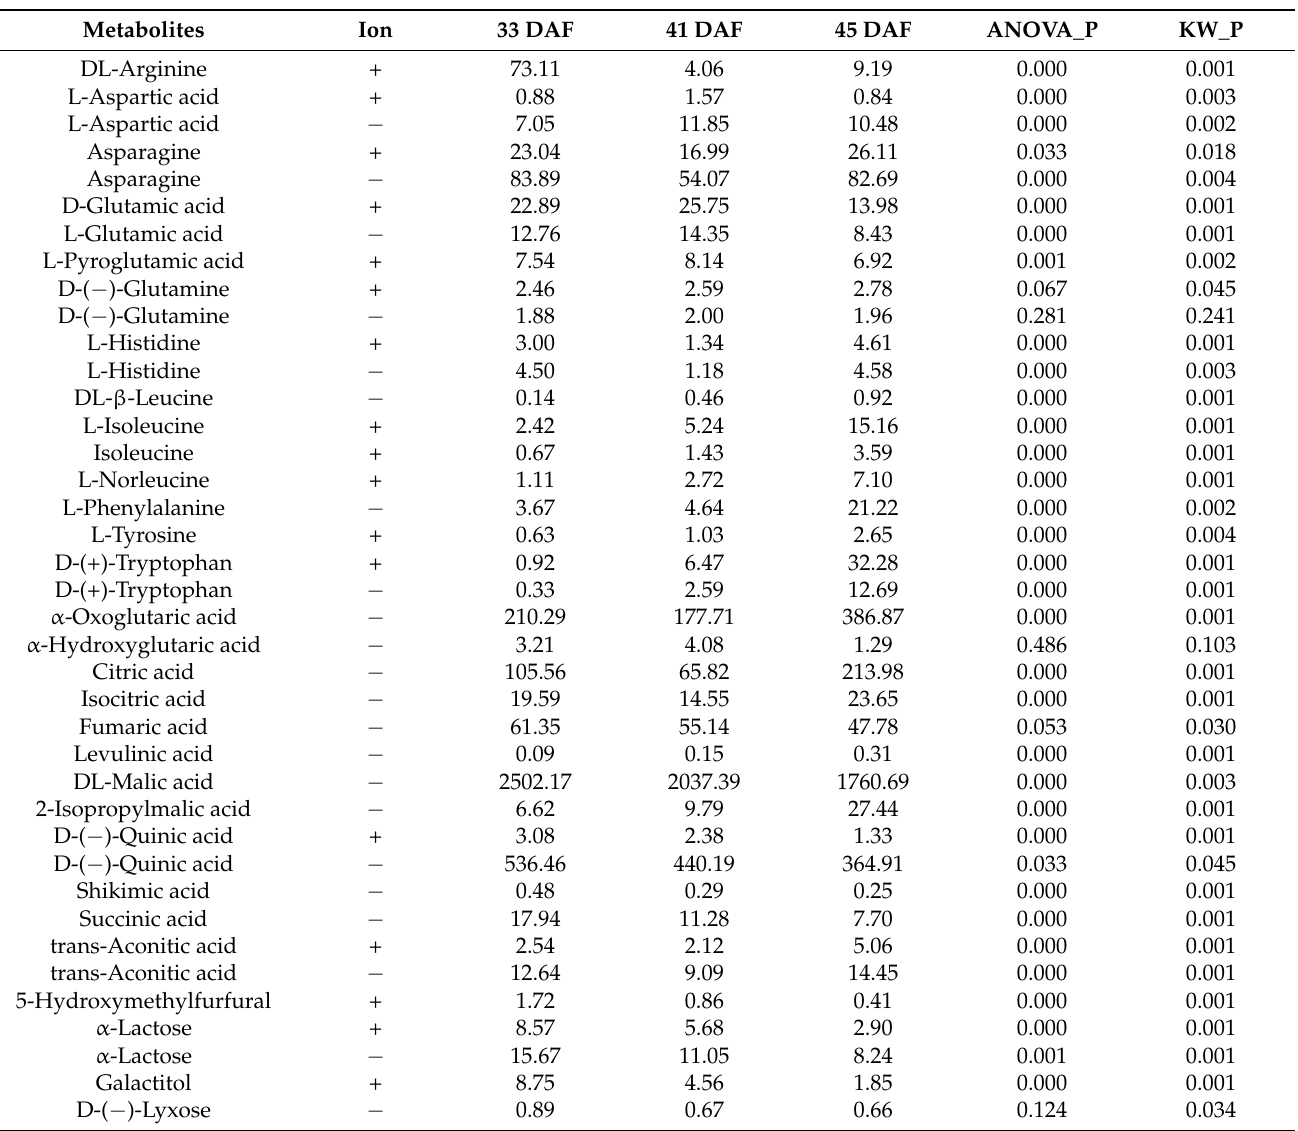
Table 2. The peak areas of amino acids, sugars and organic acids compounds during the lignifying process in the apricot endocarp (peak area, × 10 7